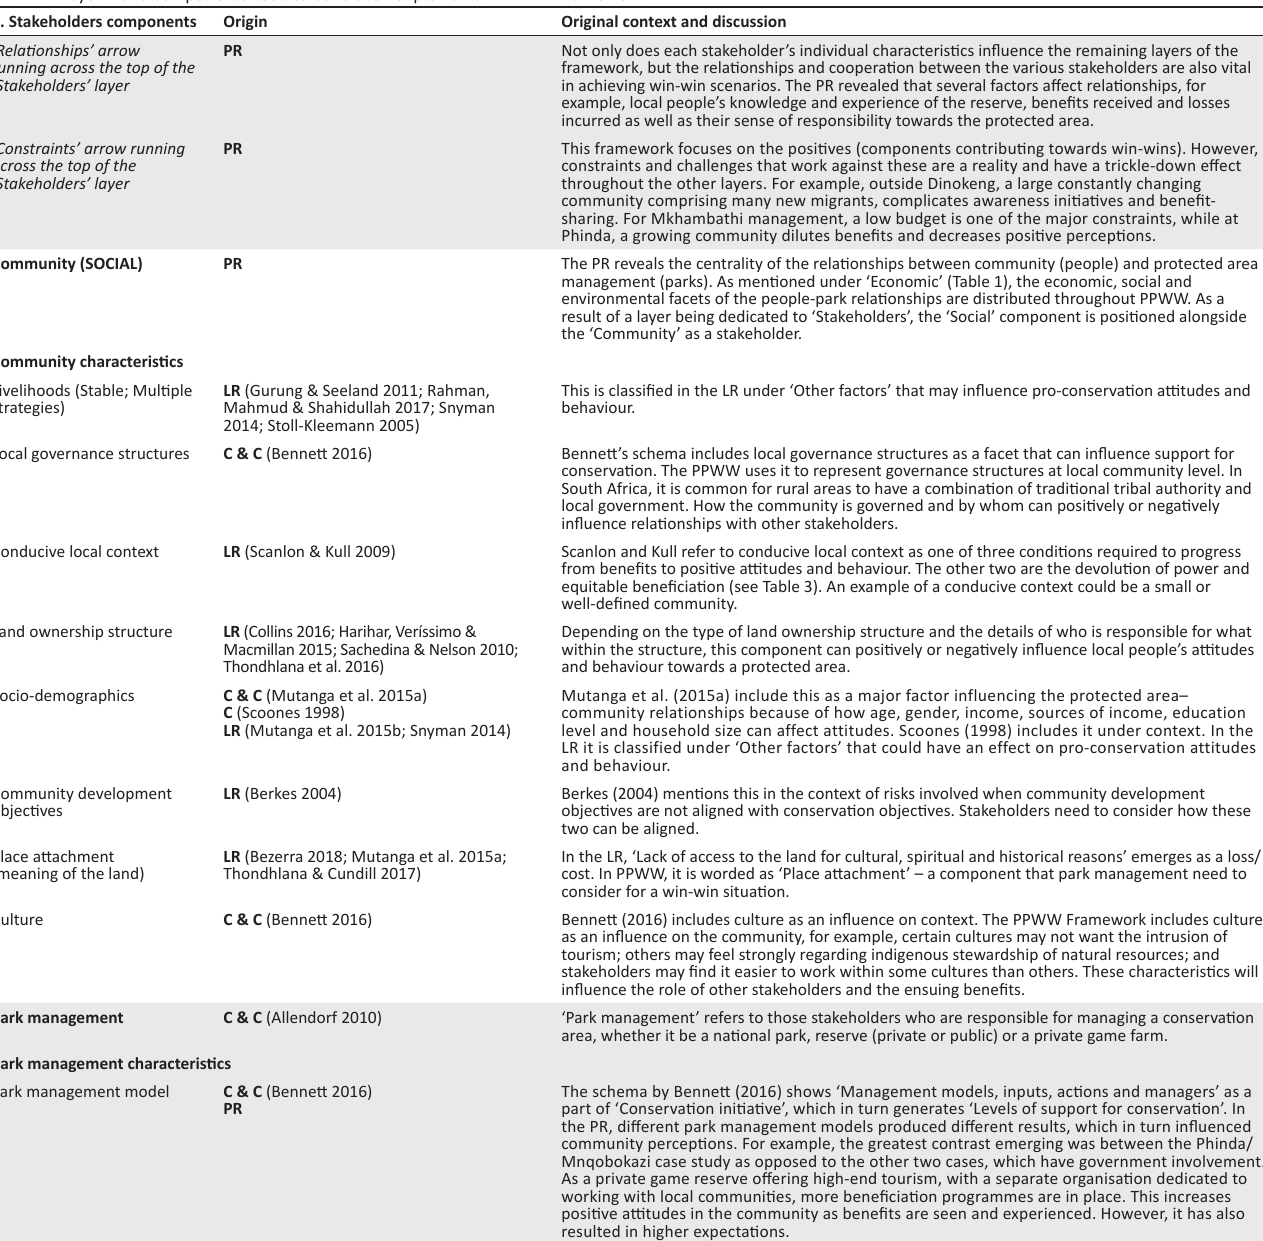
TABLE 2: Layer 2 and components used to build the People Parks Win-Win